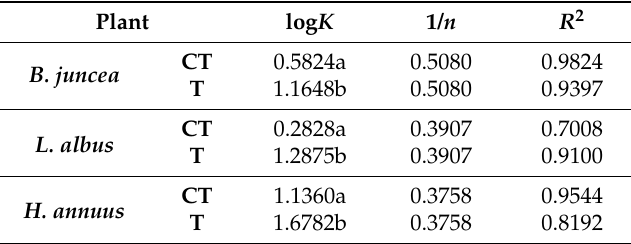
Table 6. Relationship between shoot total accumulation and As concentration in soil. Parameters of the Freundlich-like model by setting 1/ n as shared parameter.